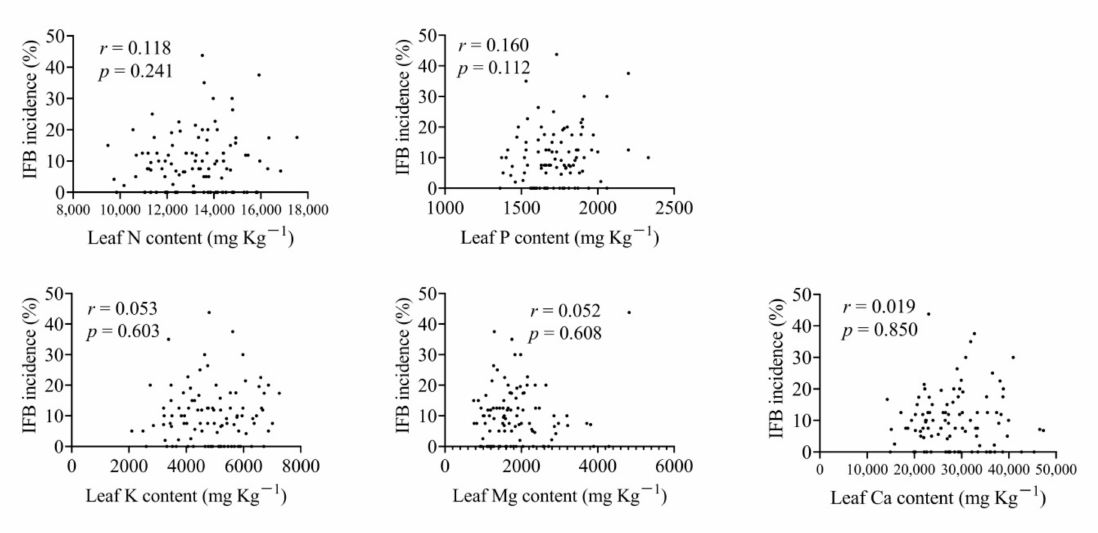
Figure 10. Relationship between IFB incidence and leaf N, P, K, Mg and Ca content in 100 mango